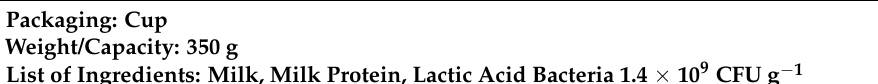
Table 1. Description of the yoghurt consumed among the participants from the experimental